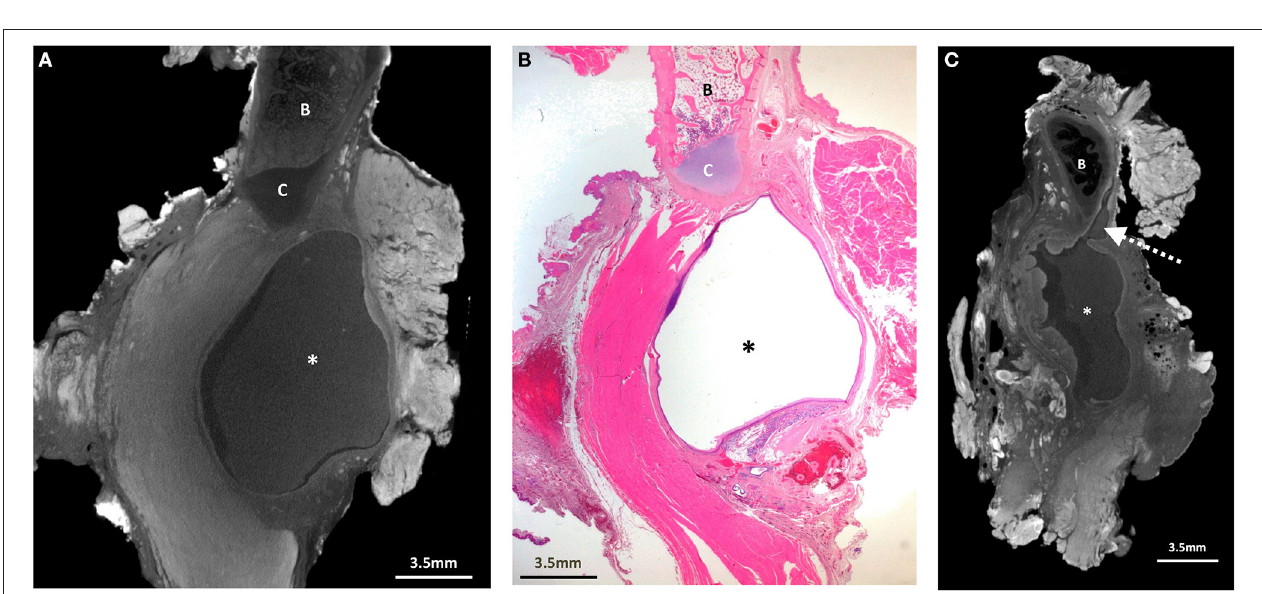
FIGURE 2 | Excised thyroglossal duct cyst specimen from a 5-year-old male patient (case 2). (A) Paired iodinated micro-CT imaging at 20.0 micron resolution and (B) histopathological section with H&E staining in sagittal section demonstrate a large bilobed thyroglossal duct cyst (*) with mixed internal contents containing blood and pus, leading to a blind ending thyroglossal duct (dashed arrows) anterior to the hyoid bone (B) and hyoid cartilage (C).